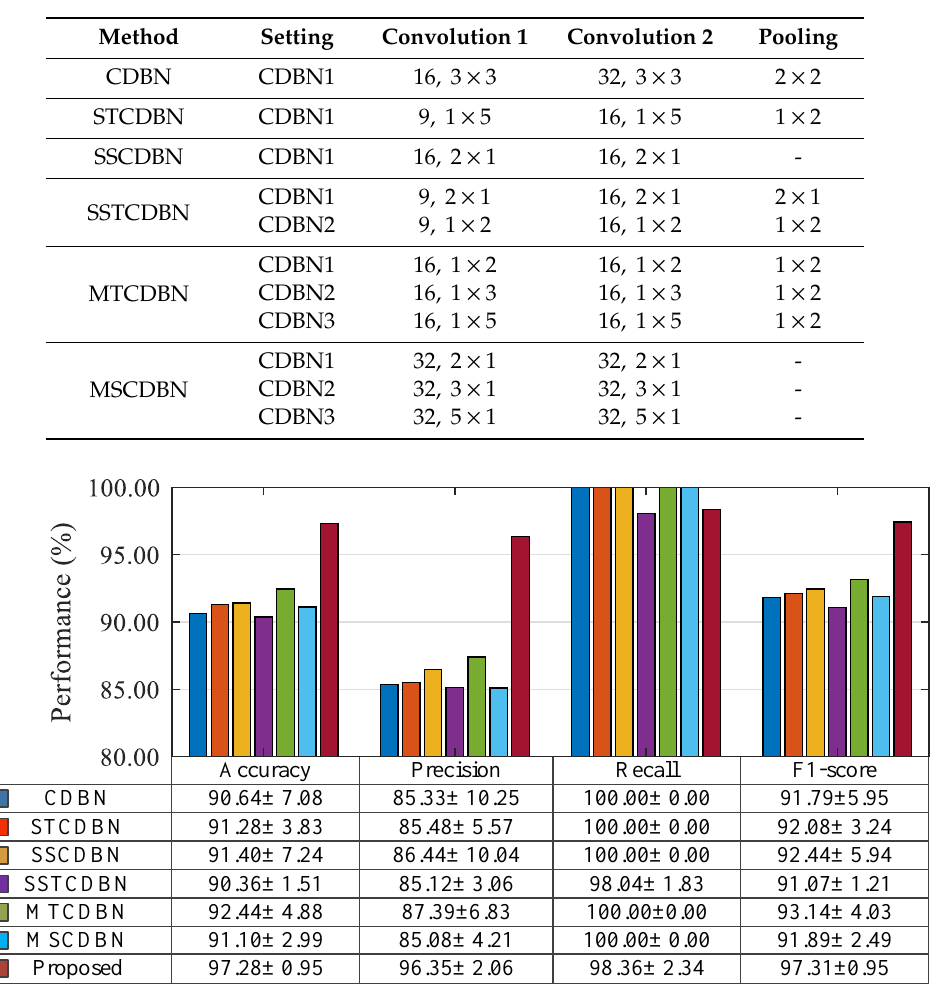
Table 5. Structures of six comparative methods.